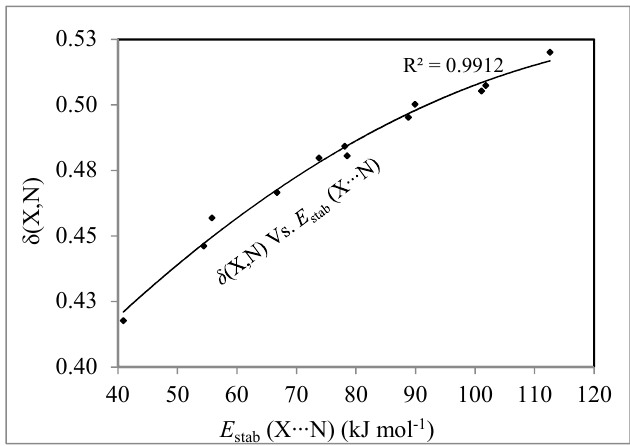
Figure 3. Relationships between E stab (X ∙∙∙ N) and δ (X,N).